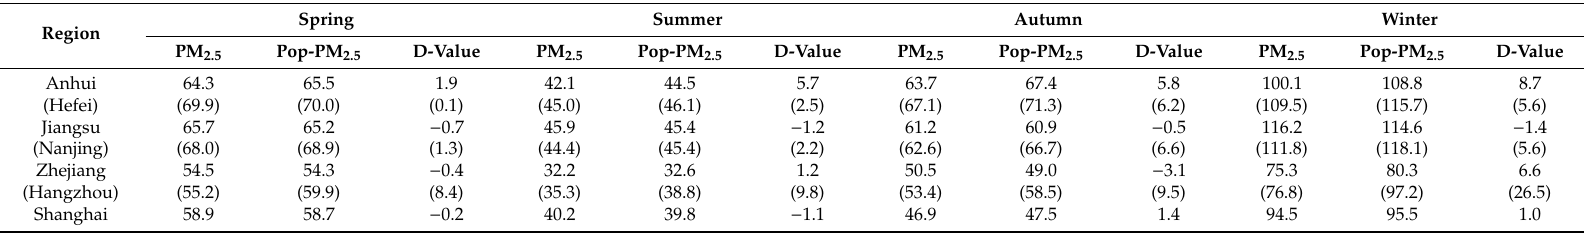
Table 3. PM 2.5 concentration ( µ g / m 3 ) and Pop-PM 2.5 concentration ( µ g / m 3 ), and their di ff erence degrees (D-value, %) in key cities and Province of four seasons in 2013. Region